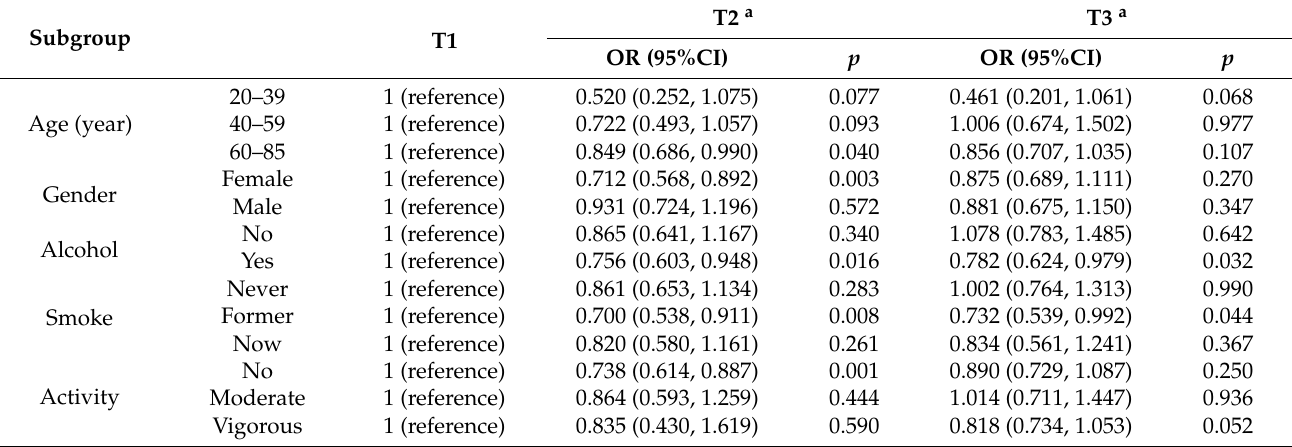
Table 3. Subgroup analysis of relationship between total antioxidant capacity and the risk of stroke among US adults.